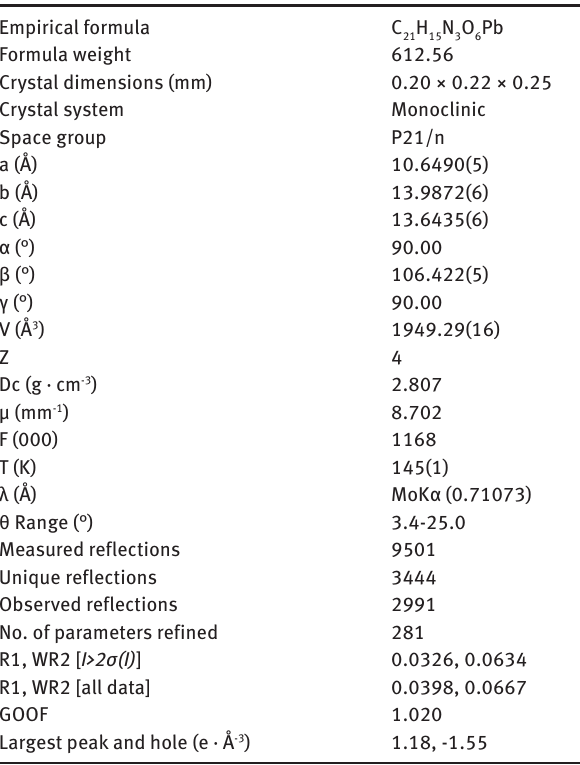
Table 4: Crystal data and refinement parameters Empirical